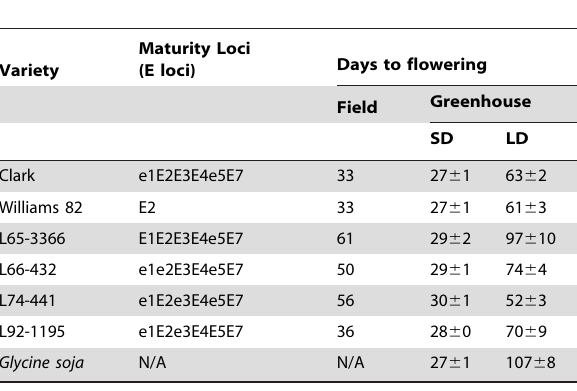
Table 1. Seven soybean inbred lines, their allele types for Maturity Loci (E loci) and the days to